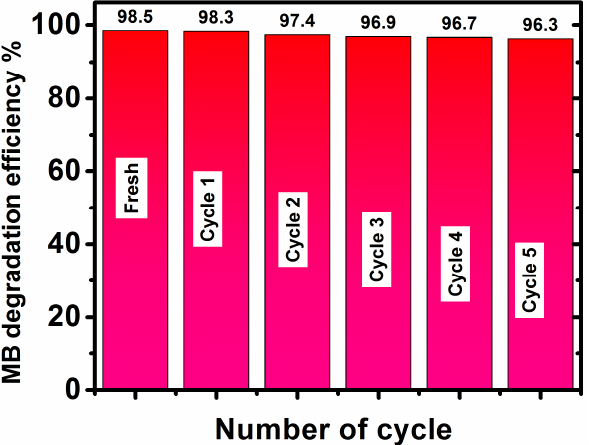
Figure 9. Reusability of MoS 2 -Cu/CuO@GN photocatalysts under same experimental conditions.